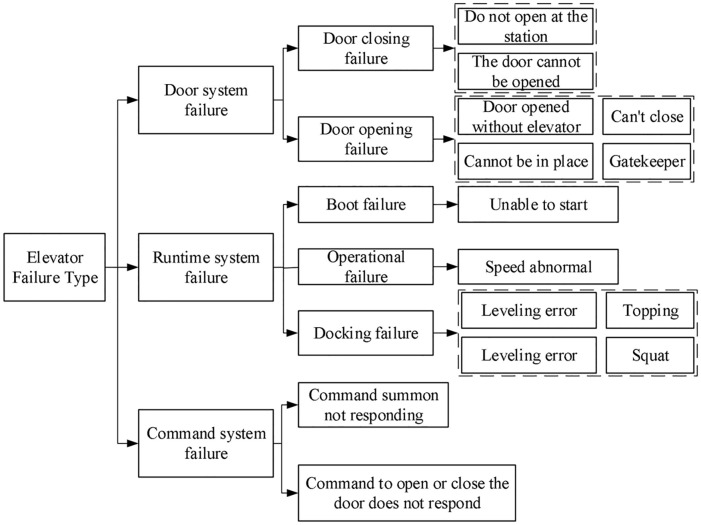
Major types of elevator failures.